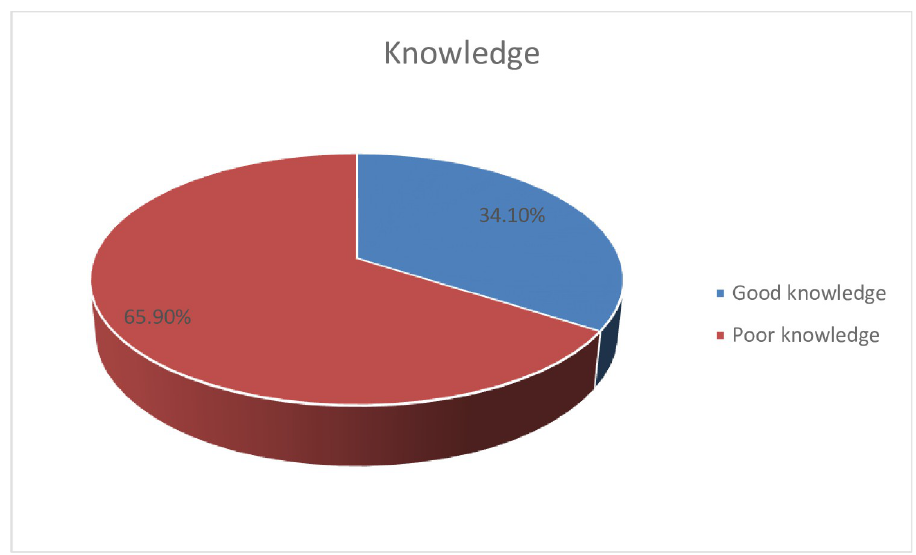
Fig 3. Knowledge of pregnant mothers about oral health during pregnancy attending antenatal care at South Omo Zone hospitals, Southern Ethiopia, 2021.